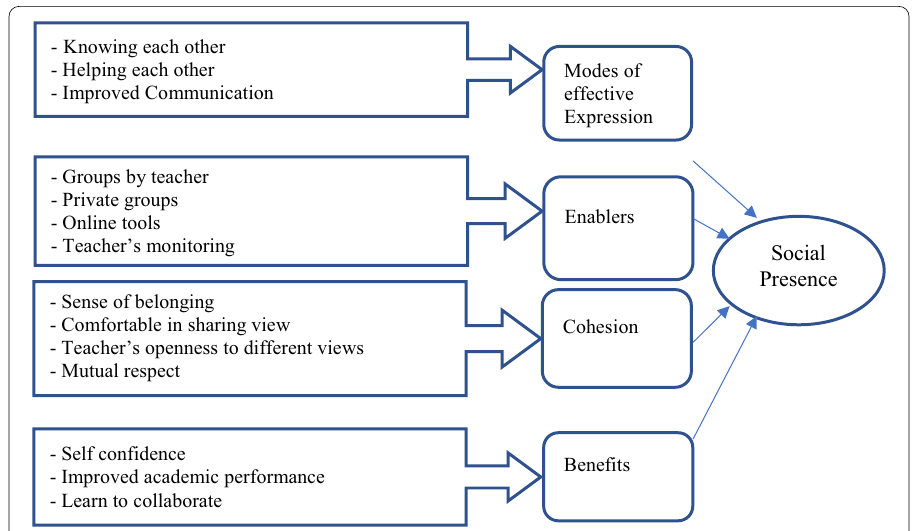
Fig. 3 Structure of students’ perceptions about social presence influence in virtual learning